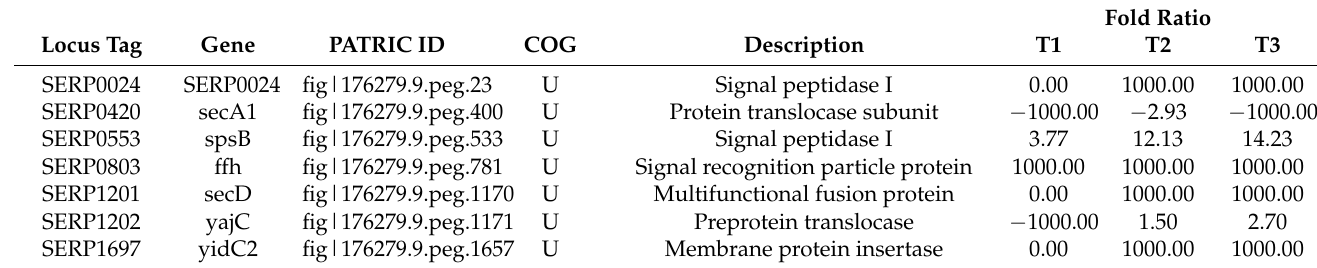
Table 6. Differentially expressed proteins associated with protein export pathway.